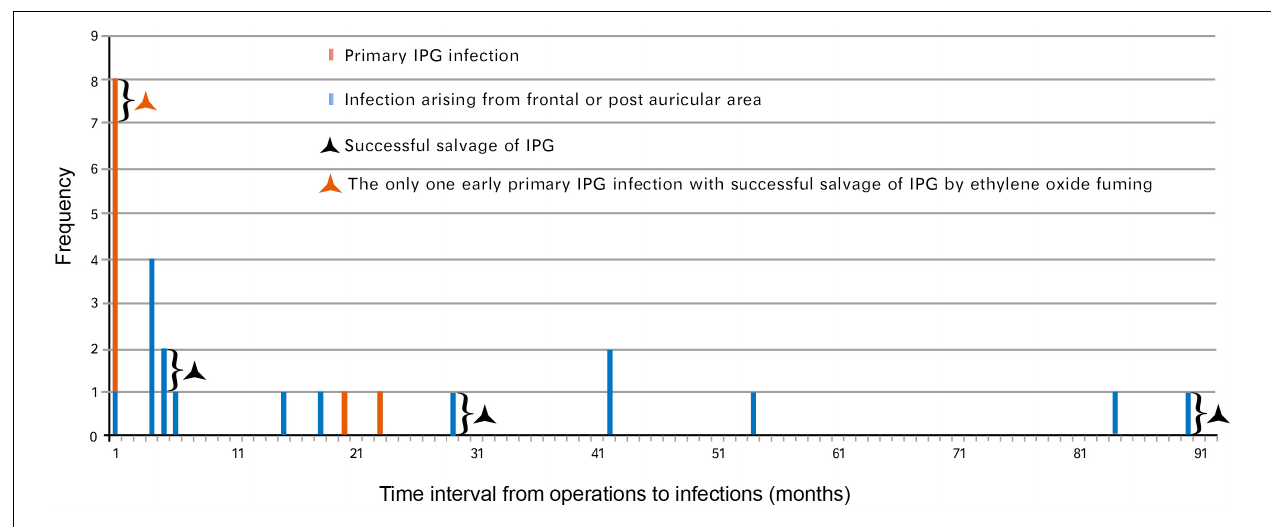
FIGURE 2 | Hardware-related infections in group A (time interval to diagnosis of infection). Twenty-five cases of hardware-related infections were enrolled in group A (between June 2005 and June 2014) based on the date of diagnosis. Eight cases presented early-onset infection while 17 cases presented late-onset infection. IPG, implantable pulse